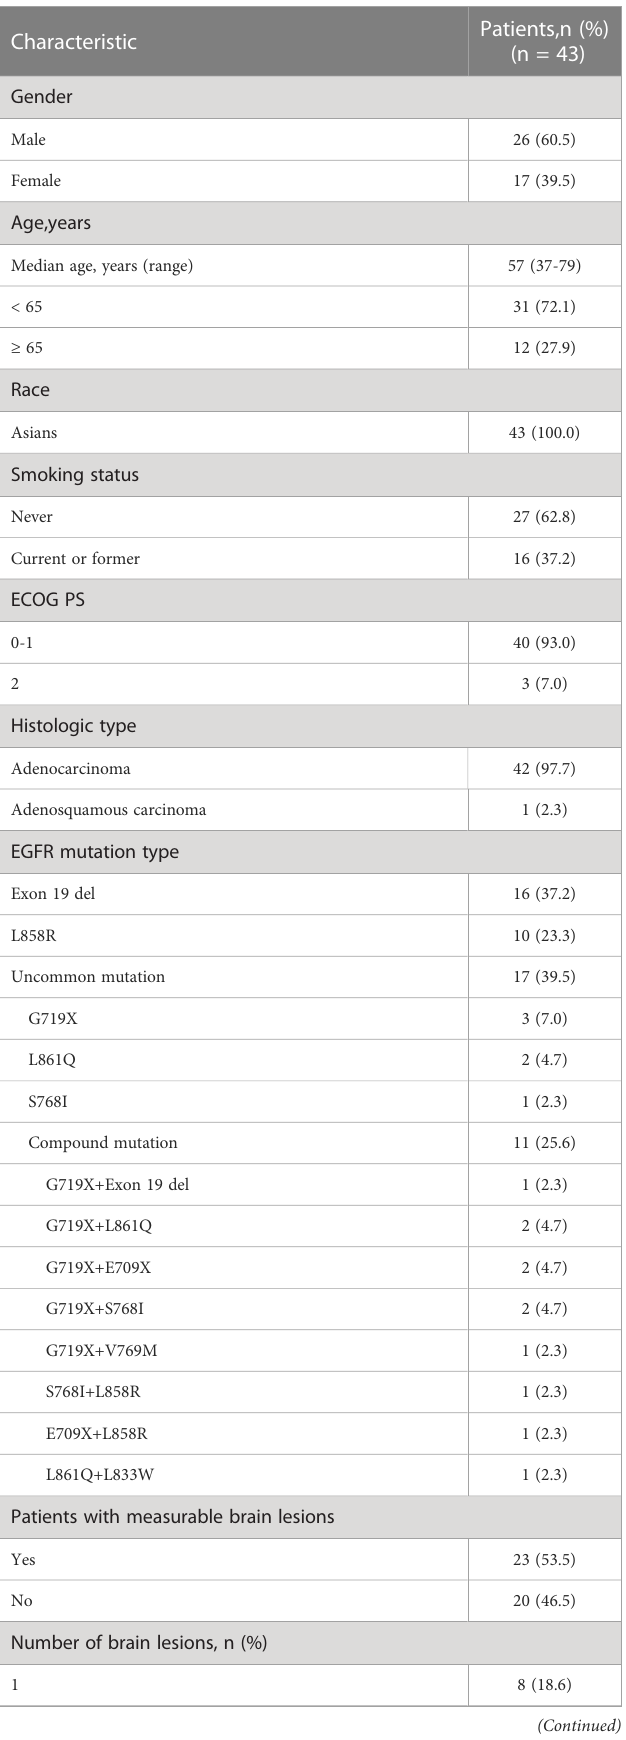
analysis for cumulative incidence of CNS failure, patients with common mutations showed a signi fi cantly lower cumulative incidence of CNS failure compared with those with uncommon